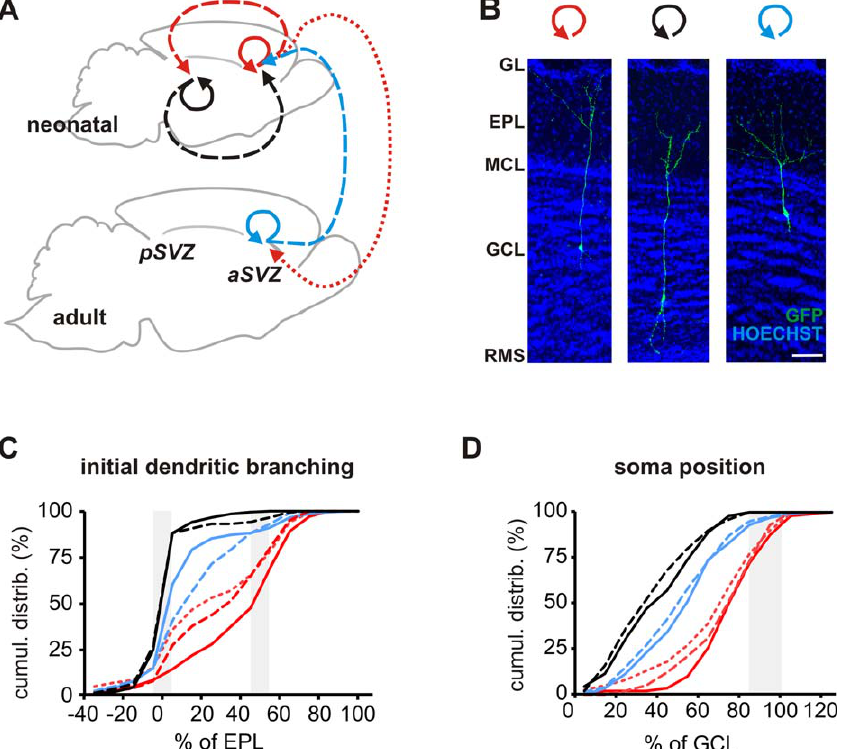
Figure 5. Transplantations of Distinct SVZ Regions Revealed Determination of Initial Dendritic Branching Patterns of GCs in Their Precursors (A) The diagram shows the different transplantation conditions from aSVZ and pSVZ donor tissue of neonatal and adult animals. (B) GCs detected 35 d post-transplantation after isochronic, isotopic transplantation of aSVZ of neonatal GFP þ rats to neonatal host aSVZ (left), pSVZ of neonatal GFP þ rats to neonatal host pSVZ (middle), and aSVZ of adult GFP þ rats to adult host aSVZ (right). The bar indicates 100 l m. (C) Cumulative distribution of initial branching point of the apical dendrite in the EPL of GCs generated from transplanted SVZ regions as described in (A) (same labeling as in [A] for the different transplantation conditions). (D) Cumulative distribution of the soma position in the GCL of GCs generated from transplantations shown in